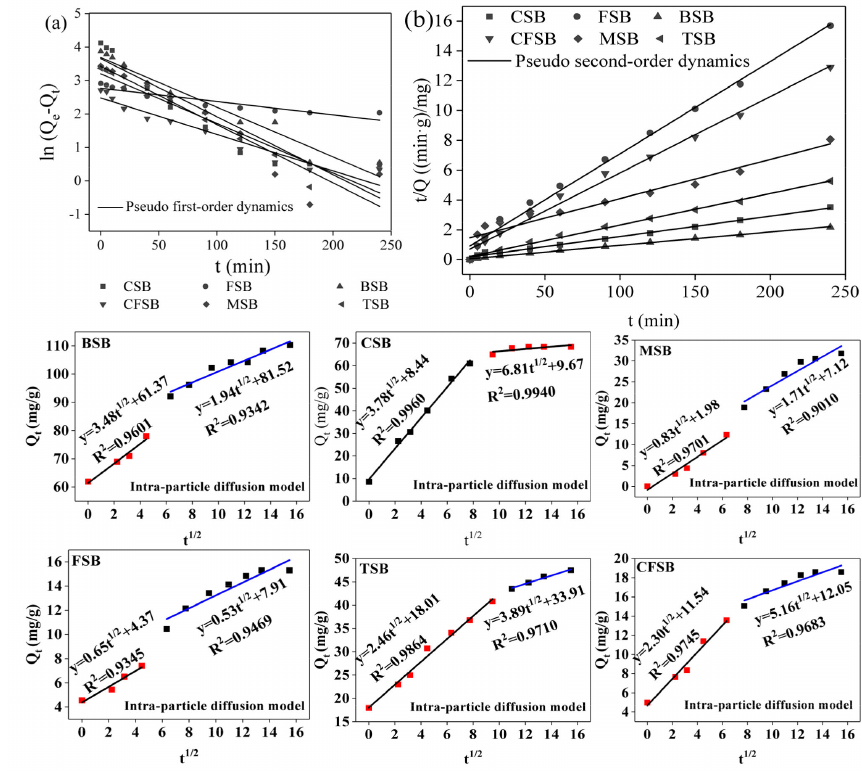
Figure 6. Adsorption kinetic curves of Cr(VI) on the six biochars (( a ): Pseudo first-order dynamics fitting curve; ( b ): Pseudo second-order dynamics fitting